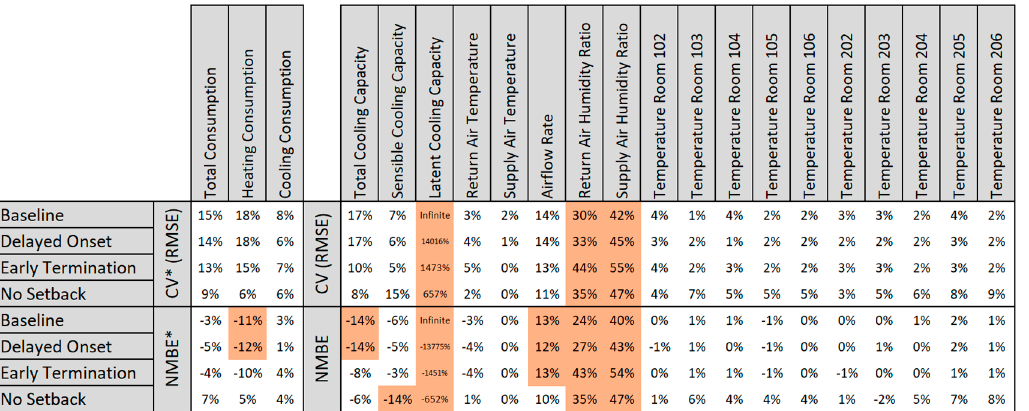
Table 4. CV (RMSE) and NMBE Calculations for Detailed Model Outputs: HVAC Setback Error Buildings 2019 , 9 , x FOR PEER REVIEW (Average of Winter and Summer).